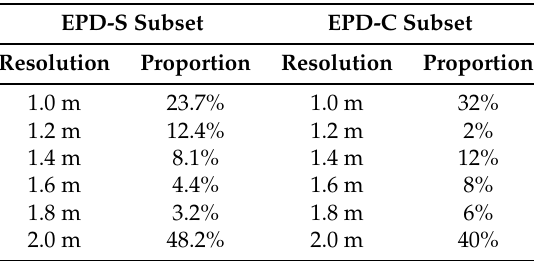
Table 6. Data distribution of mixed resolution dataset obtained by down-sampling the images of 1-m resolution in the dataset.